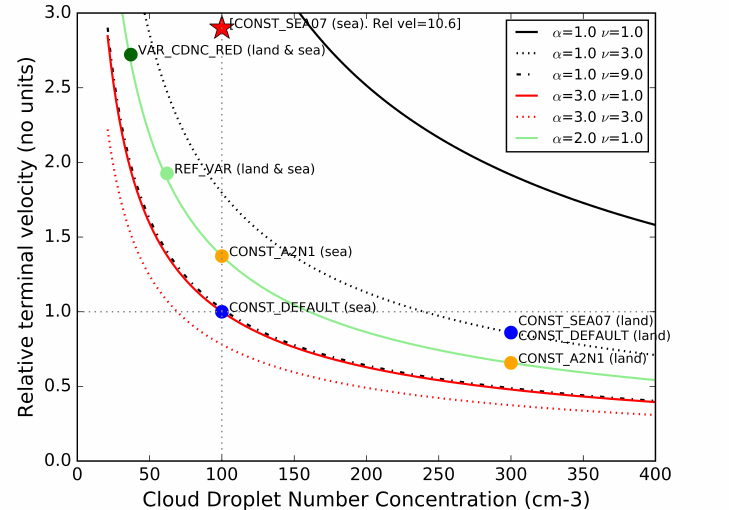
Figure 4. Relative cloud droplet terminal velocity as a function of CDNC for different values of α and ν . The shown velocities are relative to the terminal velocity corresponding to a droplet size distribution with α = 3, ν = 1, and CDNC of 100 cm − 3 . The labelled experiments are described in Section 2.3. The red star (CONST_SEA07; highest increase) draws attention to the fact that this value is outside the plot